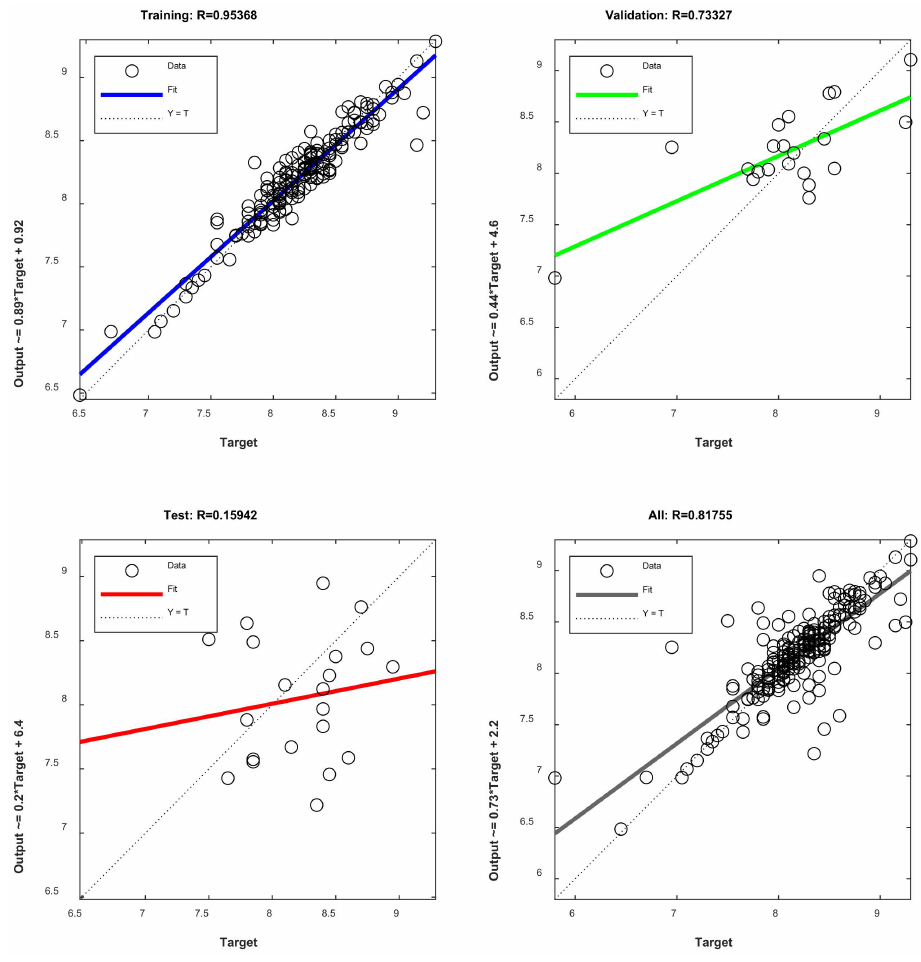
Figure 6. Classical ANN CA50 model